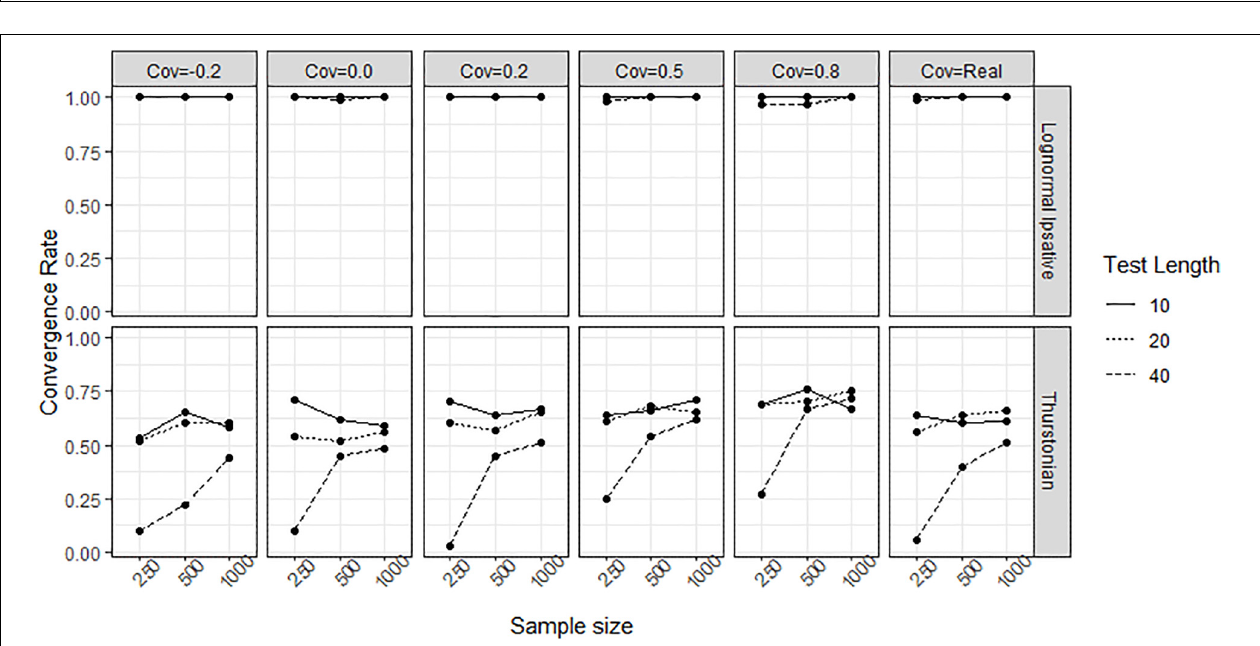
FIGURE 7 | Convergence rate obtained by fitting the lognormal ipsative model and the Thurstonian model to simulated data. The types of lines indicate the test lengths. Cov = the covariance between latent traits. Cov = Real indicates the variance-covariance matrix followed the empirical result in literature.